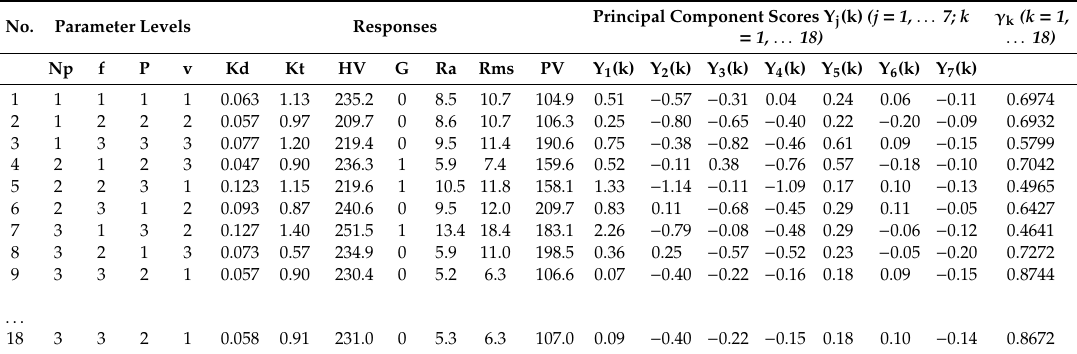
Table 5. Part of experimental plan, response values, principal components Y j (k), and gray relational grades γ k